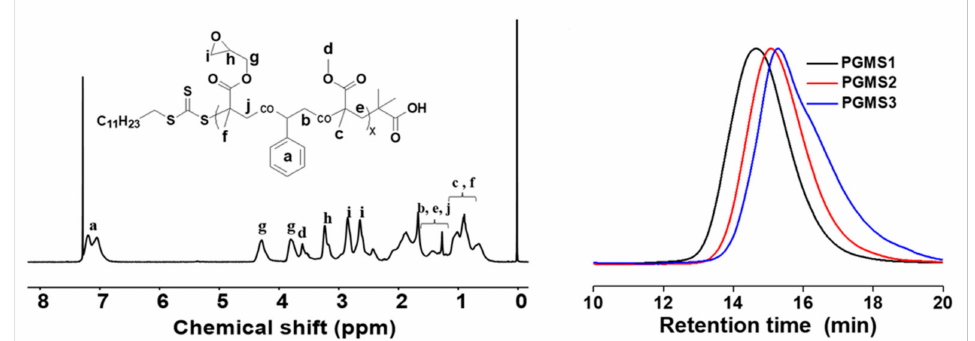
Figure 2. The 1 H NMR spectrum of PGMS in CDCl 3 ( left ) and the GPC curves of PGMS copoly- mers ( right ).